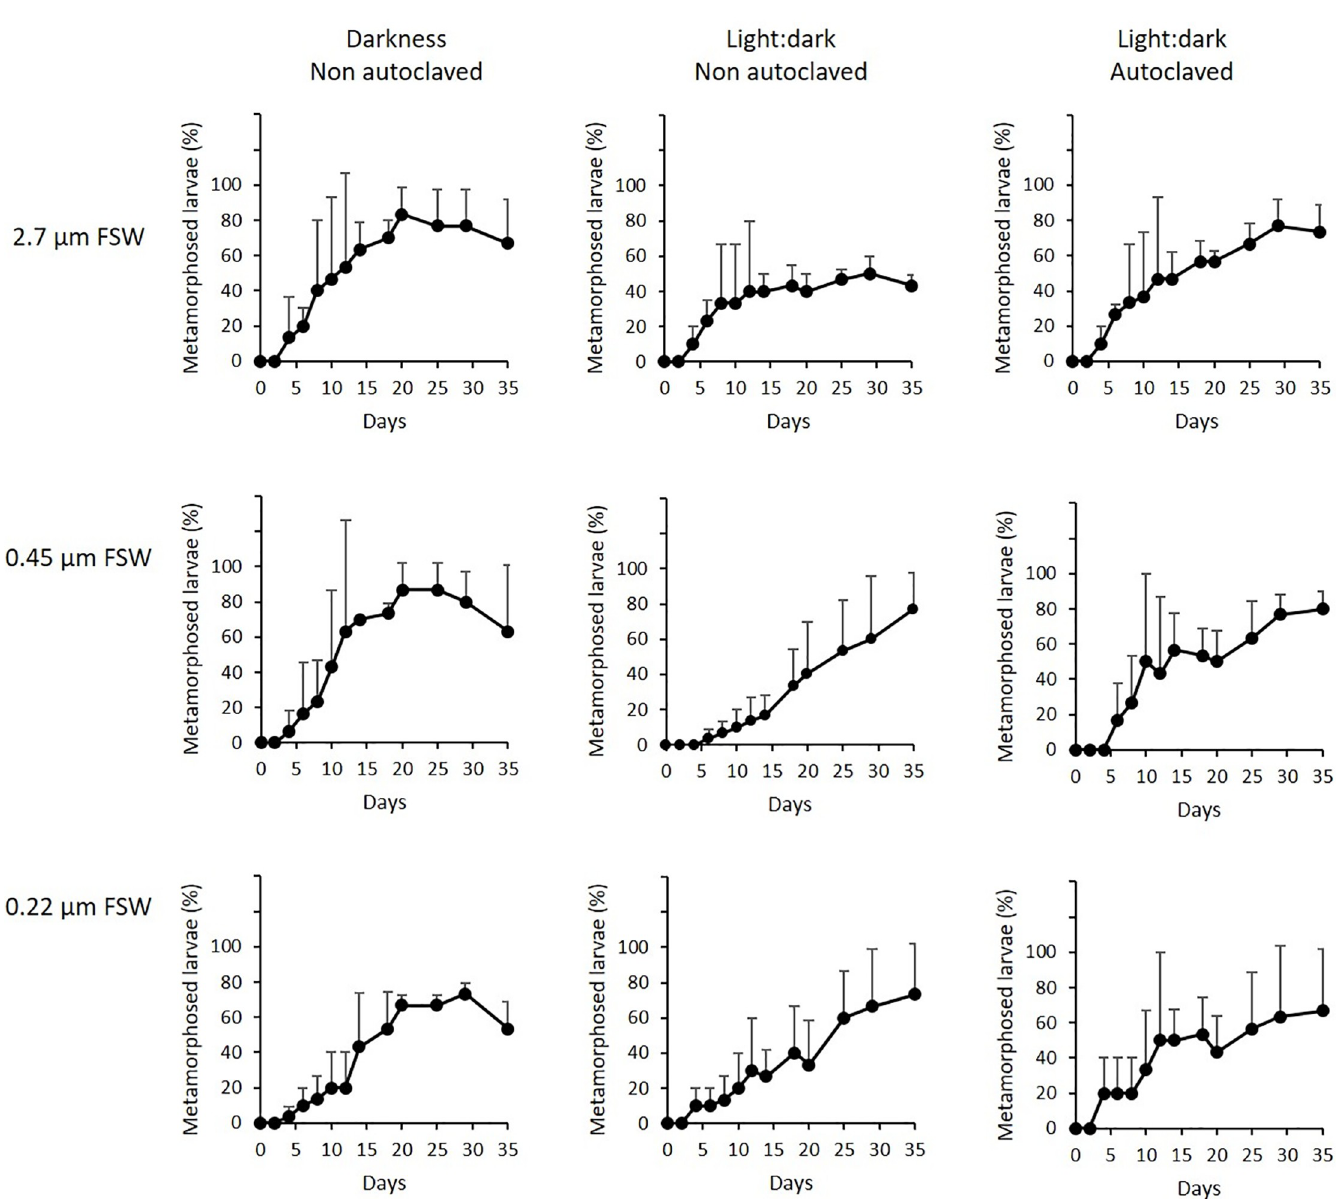
Fig 4. Number of metamorphosed Rhytisma . fulvum fulvum planulae in cultures maintained with different pore-size filtered seawater (FSW). Seawater was filtered through 2.7 μ m, 0.45 μ m, 0.22 μ m. For the cultures maintained in a light:dark cycle the effect of autoclaving the different FSW was also determined. Survival was 100% in all treatments on day 35. Half of the culture water was exchanged on alternative days. The experiment was performed with planulae harvested in 2016. Data are shown as means ± S.D. (n = 3, 10 planulae per replicate).